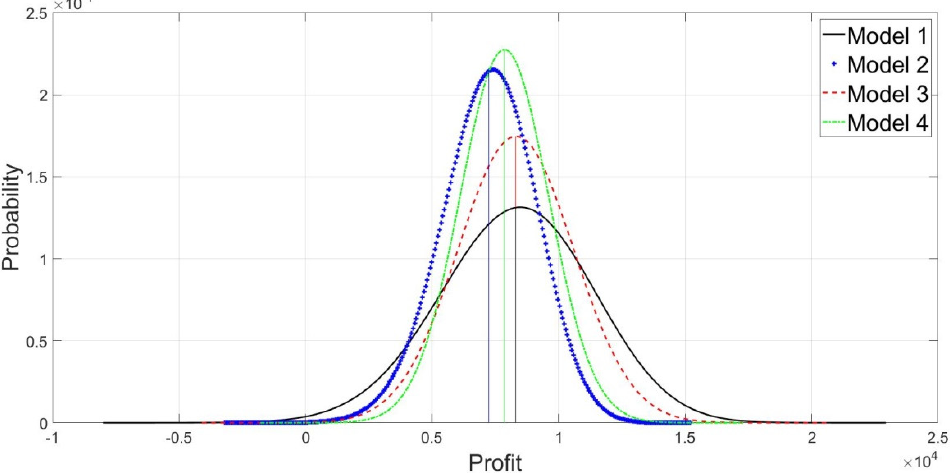
Figure 11. Profit distribution under profit maximization with no forward scenario (black line, Theorem 1), utility maximization with no forward (blue + , Theorem 2); profit maximization with forward (red –, Theorem 3); and utility maximization with forward (green —, Theorem 4). Table 4. Profit distribution of the four models.